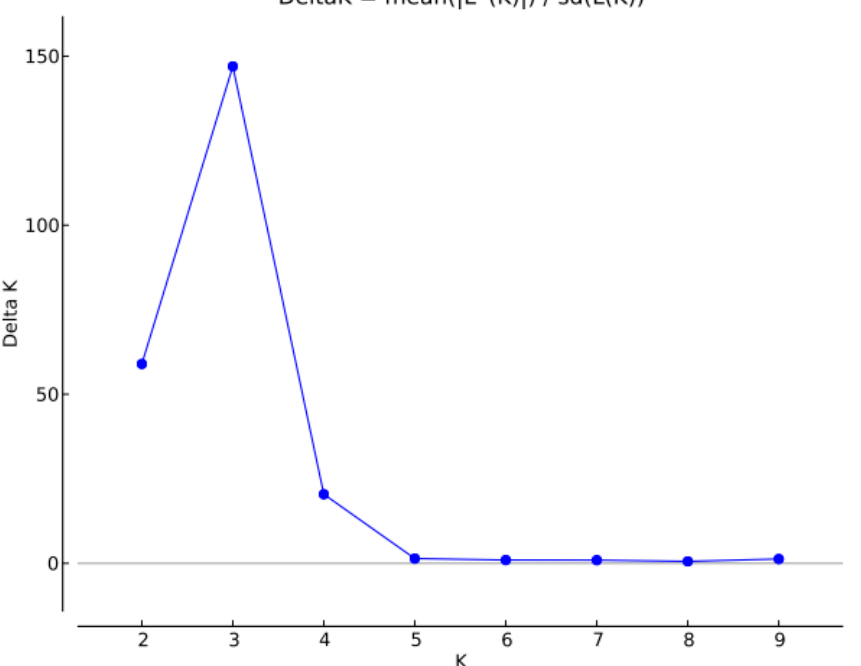
Figure 3. Δ K peak, indicating the optimal number of genetic clusters for Bayesian analysis with software Structure 2.3.4. UENF, Campos dos Goytacazes, RJ, 2021.